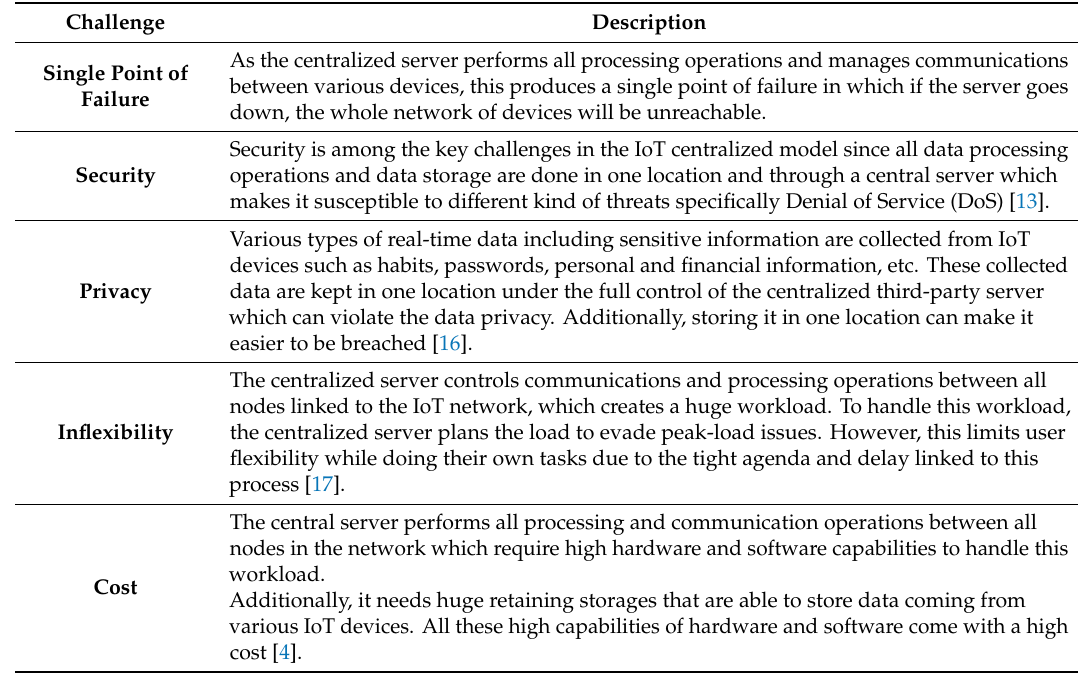
Table 1. Summary of challenges of the IoT centralized